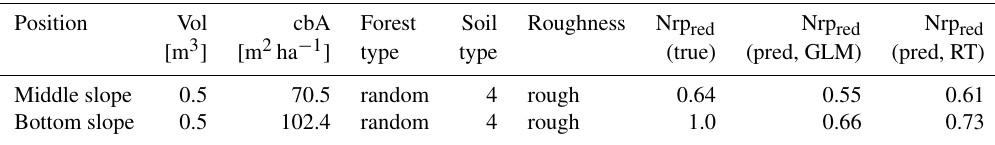
Table 5. Model input parameters and predicted values of Nrp red with the GLM and the RT model as well as the measured value for Nrp red for the study site in Vaujany where (Dorren et al., 2006) performed real-size rockfall experiments. Position Vol cbA